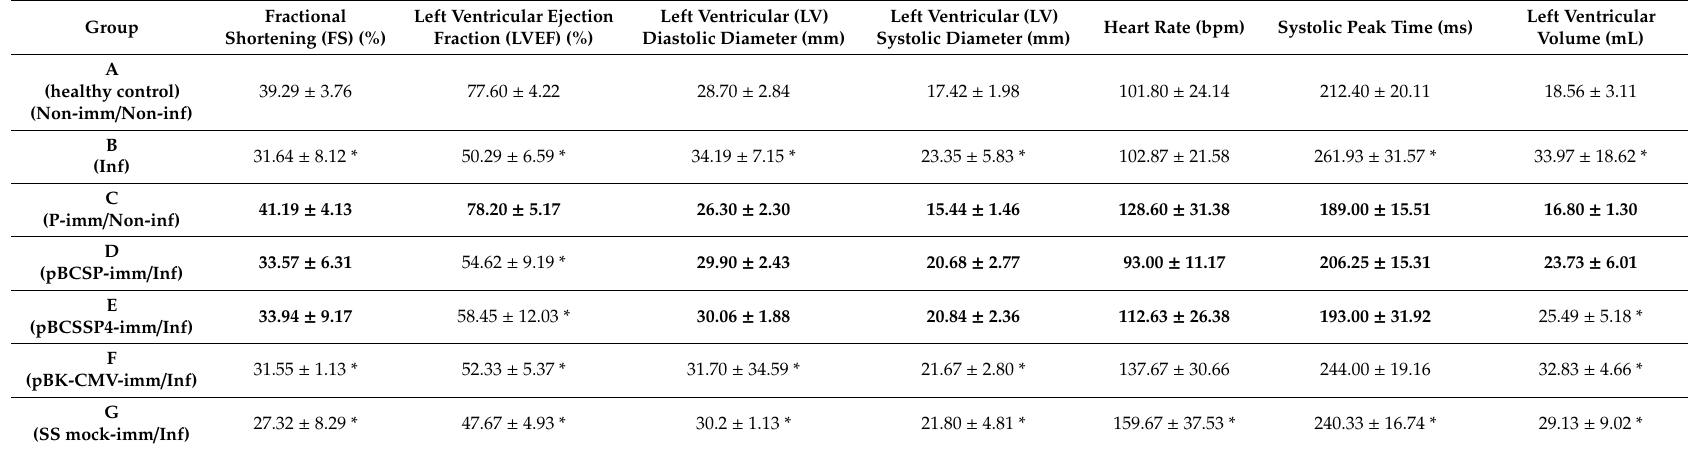
Table 2. Cardiovascular parameters in T. cruzi experimentally infected dogs immunized with DNA vaccine containing the genes encoding a trans -sialidase protein (pBCSP) or an amastigote-specific glycoprotein (pBCSSP4). Group